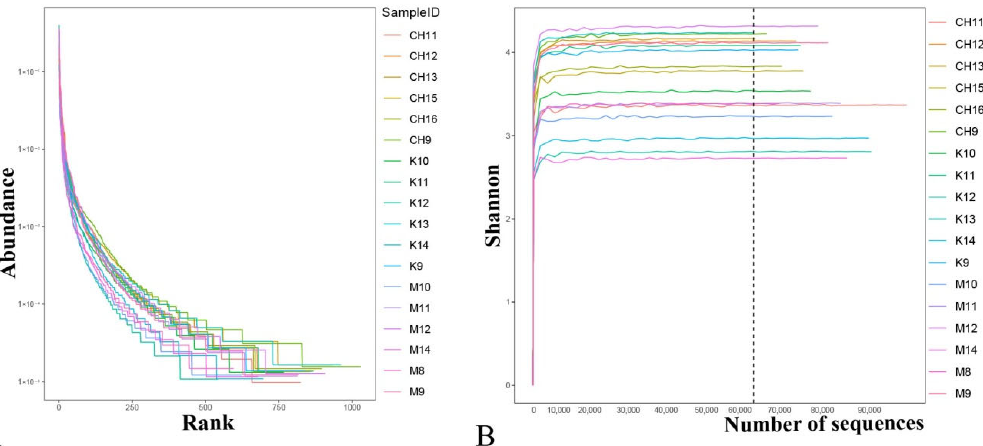
Figure 3. Analysis of uniformity and richness of species in samples. Note: ( A ) Rank abundance curve; ( B ) Shannon curves; K refers to the normal control group, CH refers to the CASP intervention group, and M refers to the model group. The same as below.